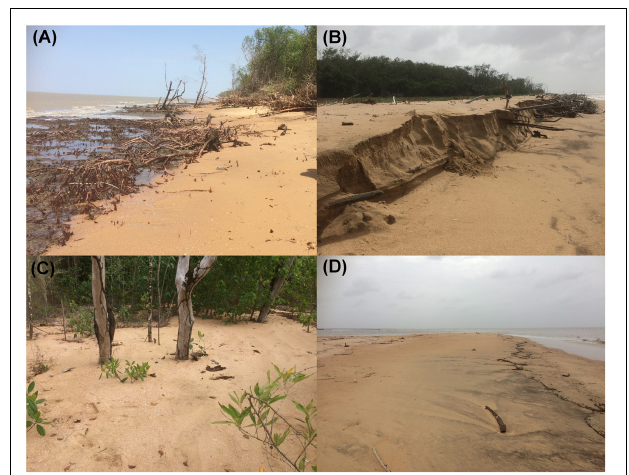
FIGURE 13 | Ground photographs showing: (A) landward-migrating (type 2) chenier forming the present updrift sector of Braamspunt beach. Westward migration of the eroding trailing edge of the inter-bank zone (uprooted mangroves) in response to impingement of the leading edge of the incoming mud bank (not visible here) is leading to shortening of the exposed length of beach. Landward chenier migration leads to the exposure, on the beach foreshore, of more or less consolidated former back-beach mud rich in mangrove remains; (B) pronounced beach scarp resulting from erosion of a steep, reflective type 1 chenier beach face (S1 and S3 in Figure 12A ) with accumulation of mangrove debris (logjams) in the background); (C) view toward the back-beach (S2 in Figure 12A ) showing washovers encroaching on Avicennia g. mangroves and burying their pneumatophores (breathing root network), leading to asphyxia and death of the plants; (D) downdrift sand transport terminus and partial sink where Braamspunt beach forms a spit in response to wave refraction caused by the Suriname River mouth re-entrant. The refracting wave front is visible in the right background. Darker shades of sand on the beach correspond to heavy minerals (black sands) deposited in this area of relatively lower wave energy as a result of refraction, and further concentrated by mild wind sorting of the beach sand. Washover lobes inherited from the higher spring tides at the start of the survey are present in the left